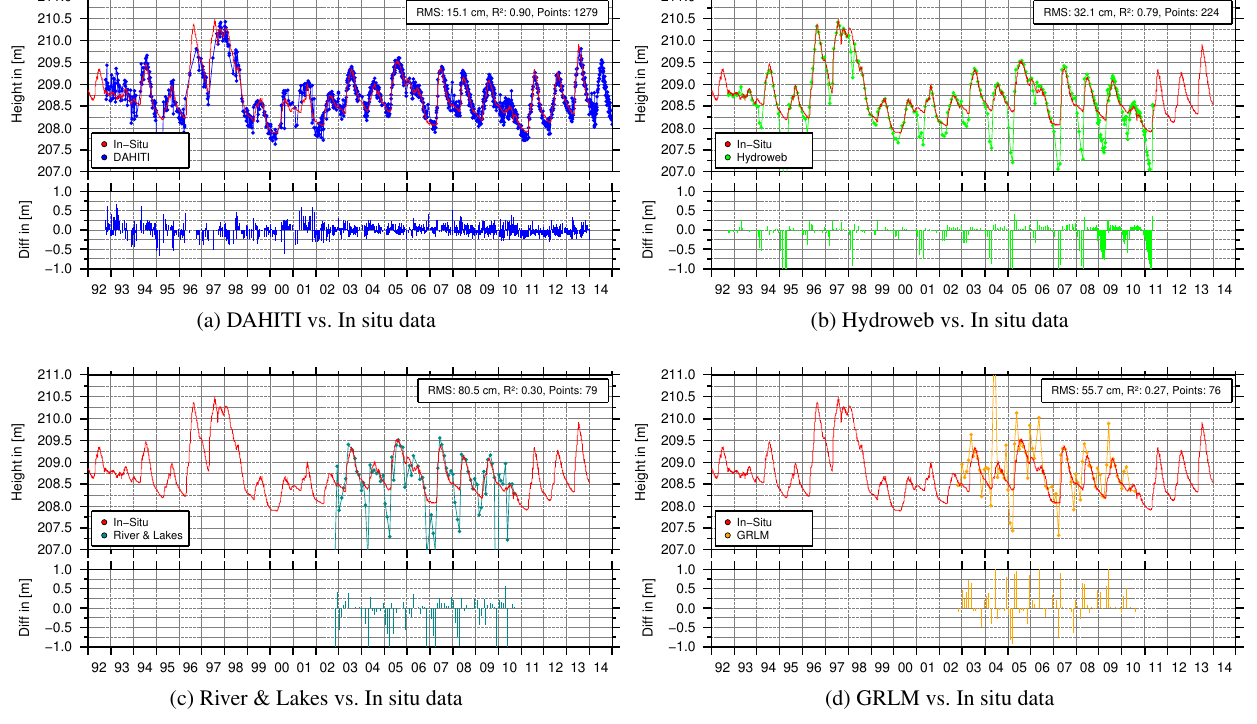
Figure 7. Water level time series of Lake Athabasca from DAHITI (1992–2014), Hydroweb (1992–2011), River & Lake (2002–2010) and GRLM (2002–2014) compared with in situ data (Lake Athabasca, 1992–2013) and shifted to the water level height of the in situ data. Additionally, differences between heights from altimetry and in situ data are plotted for periods in which both data sets are available. day with at least one altimeter track crossing the lake. During computation of the final water level time series 24 % of the data are rejected, mostly because of ice